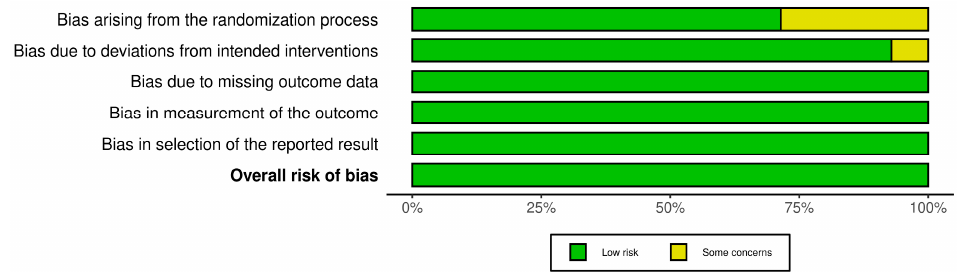
Figure 3. Risk of bias assessment according to RoB2: Overall rating.